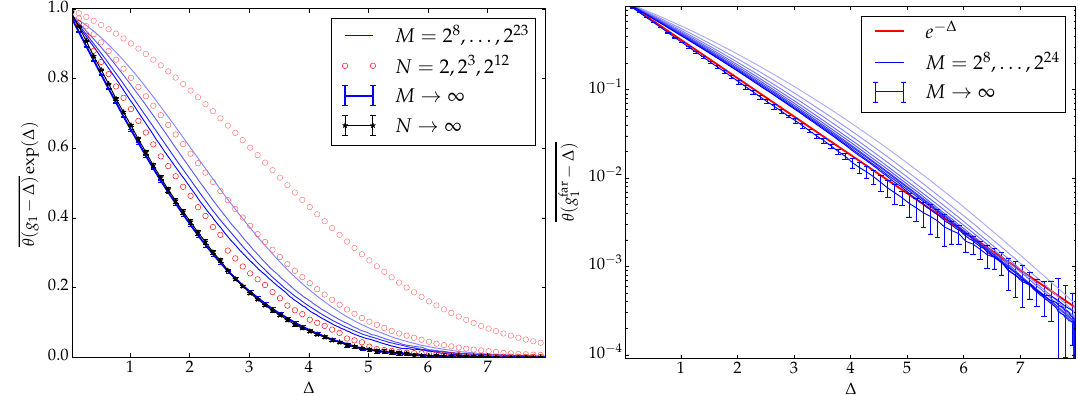
Figure 4: Left: Global vs local first gap distribution in the circular 1 / f -noise model. The global gaps are measured directly from systems of sizes M = 2 8 ,2 13 ,2 18 ,2 23 , and extrapolated point wise by the 1 / ln M -quadratic finite size Ansatz. The results (blue curves) are multiplied by exp ( ∆ ) (note that an exponential distribution would give a horizontal line at height 1). The first gap of the biased process is measured by (35), in local logREMs of sizes 2 ≤ N ≤ 2 12 (red circles), and extrapolated using the same Ansatz to N → ∞ (black circles). The good agreement between the latter curve ( without multiplying by exp ∆ ) and the M → ∞ curve confirms the prediction (37). Right: the far-gap distribution g far , defined in (50), with N = (cid:112) 1 M , compares well to the exponential, (51)